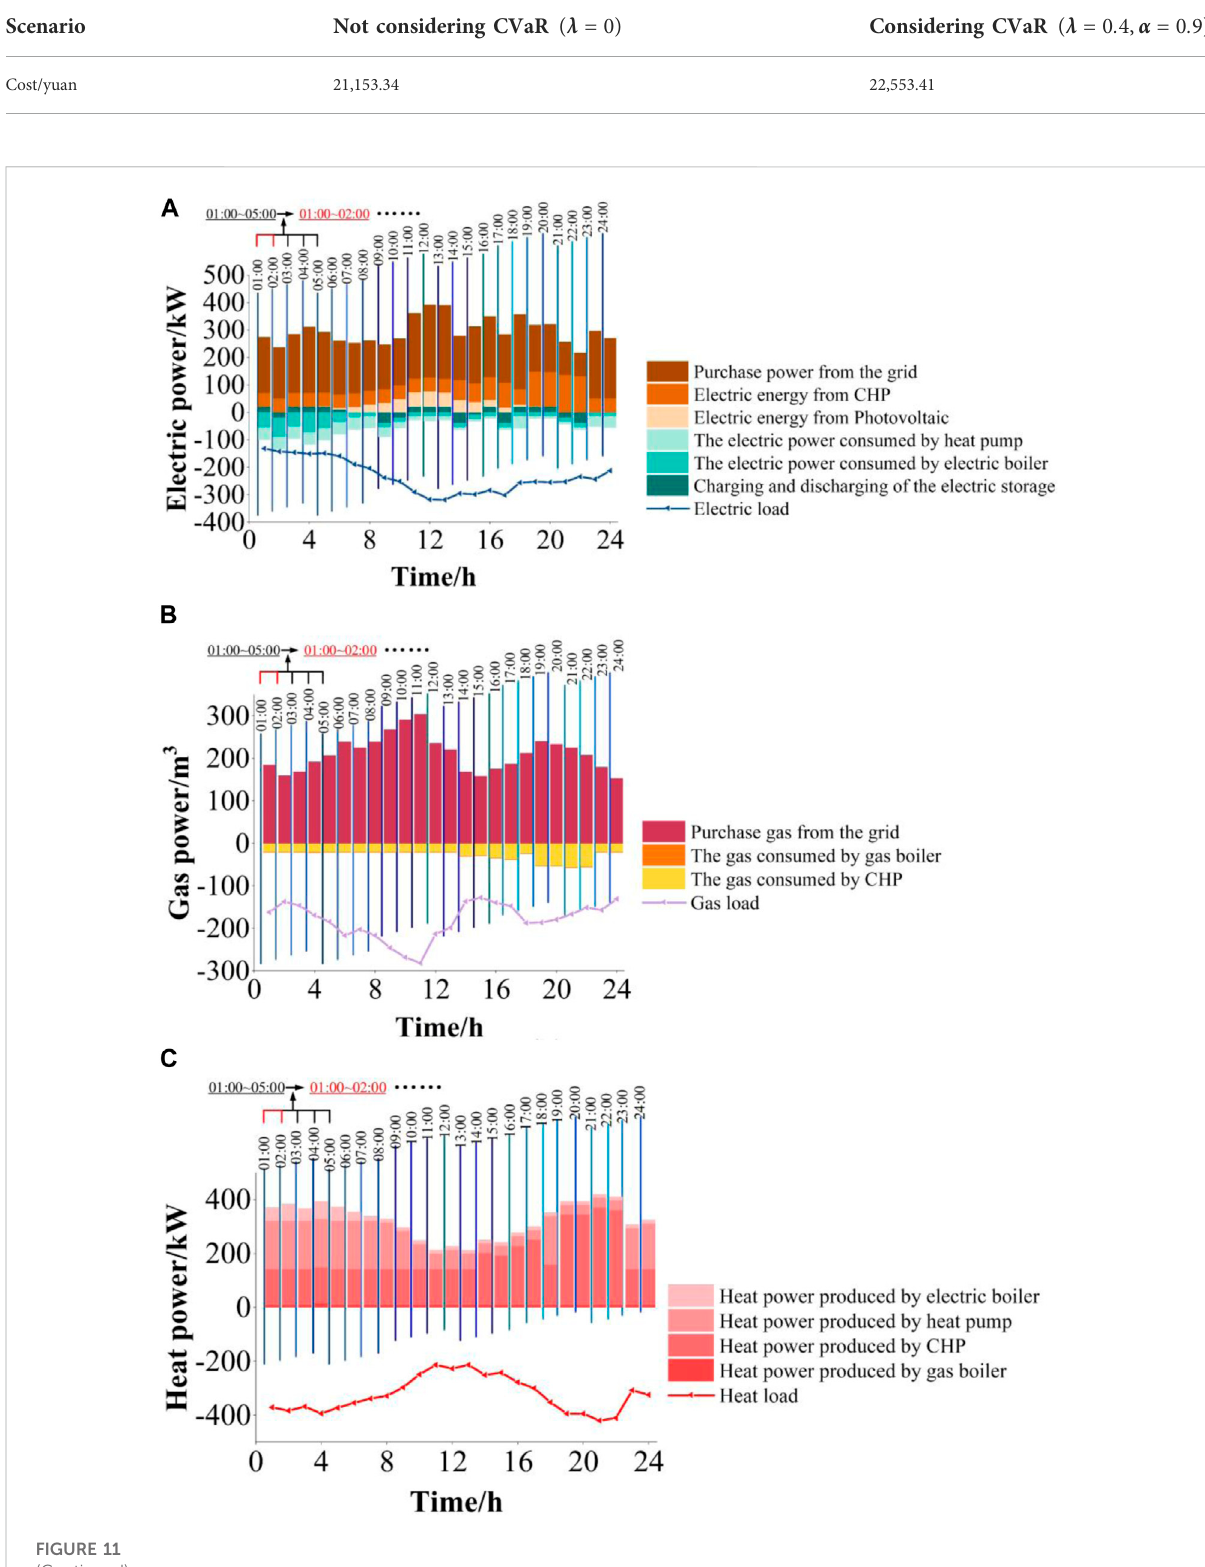
TABLE 7 Comparison of day-ahead scheduling costs considering CVaR and not considering